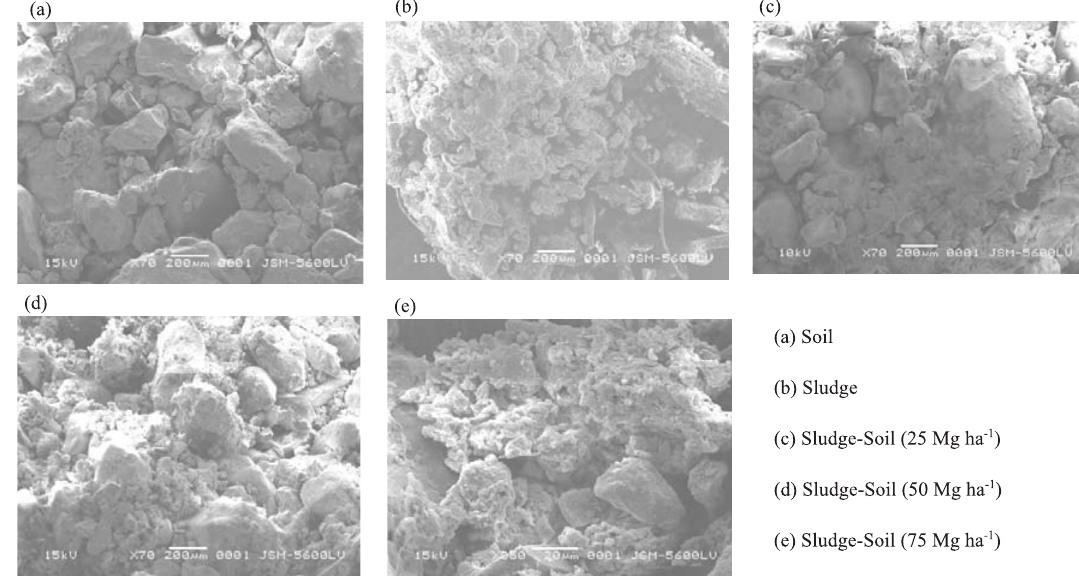
Figure 5. Electronmicrographs of the contexture of soil, sludge and sludge-soil mixtures.